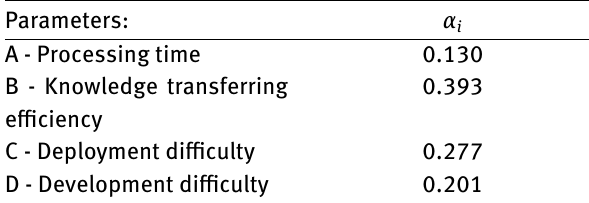
Table 8: Calculation of effectiveness in accordance with knowledge